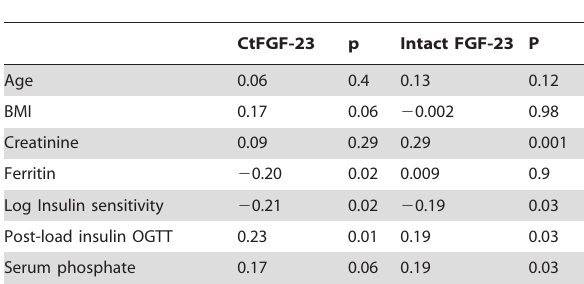
Table 3. Linear correlation analysis of the association between circulating intact and CtFGF-23 levels and selected variables in Cohort